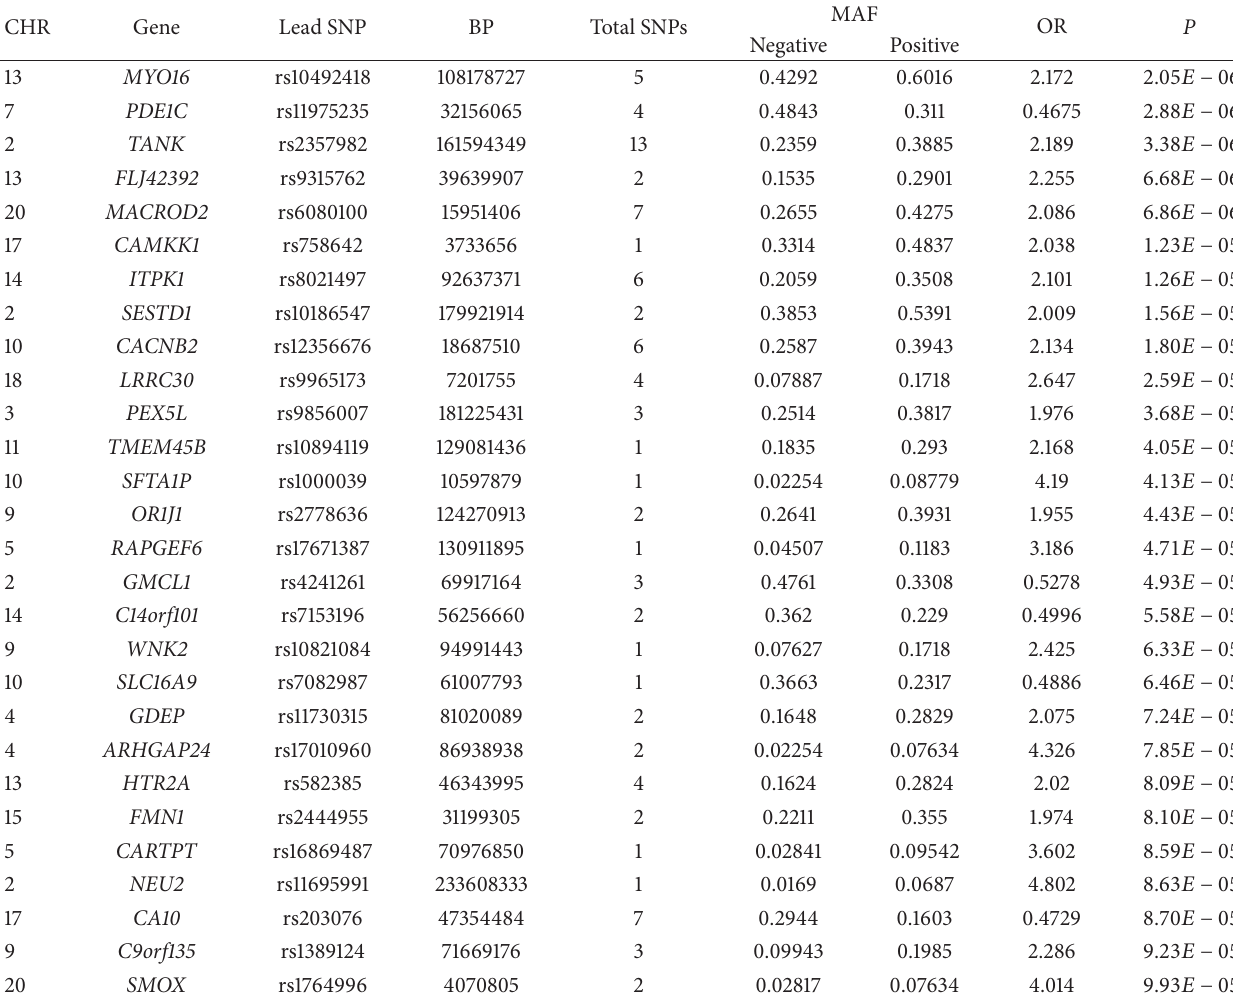
Table 4: Genetic loci associated with the occurrence of anti- 𝛽 2 GPI antibodies with 𝑃 < 1𝐸 − 04 ∗